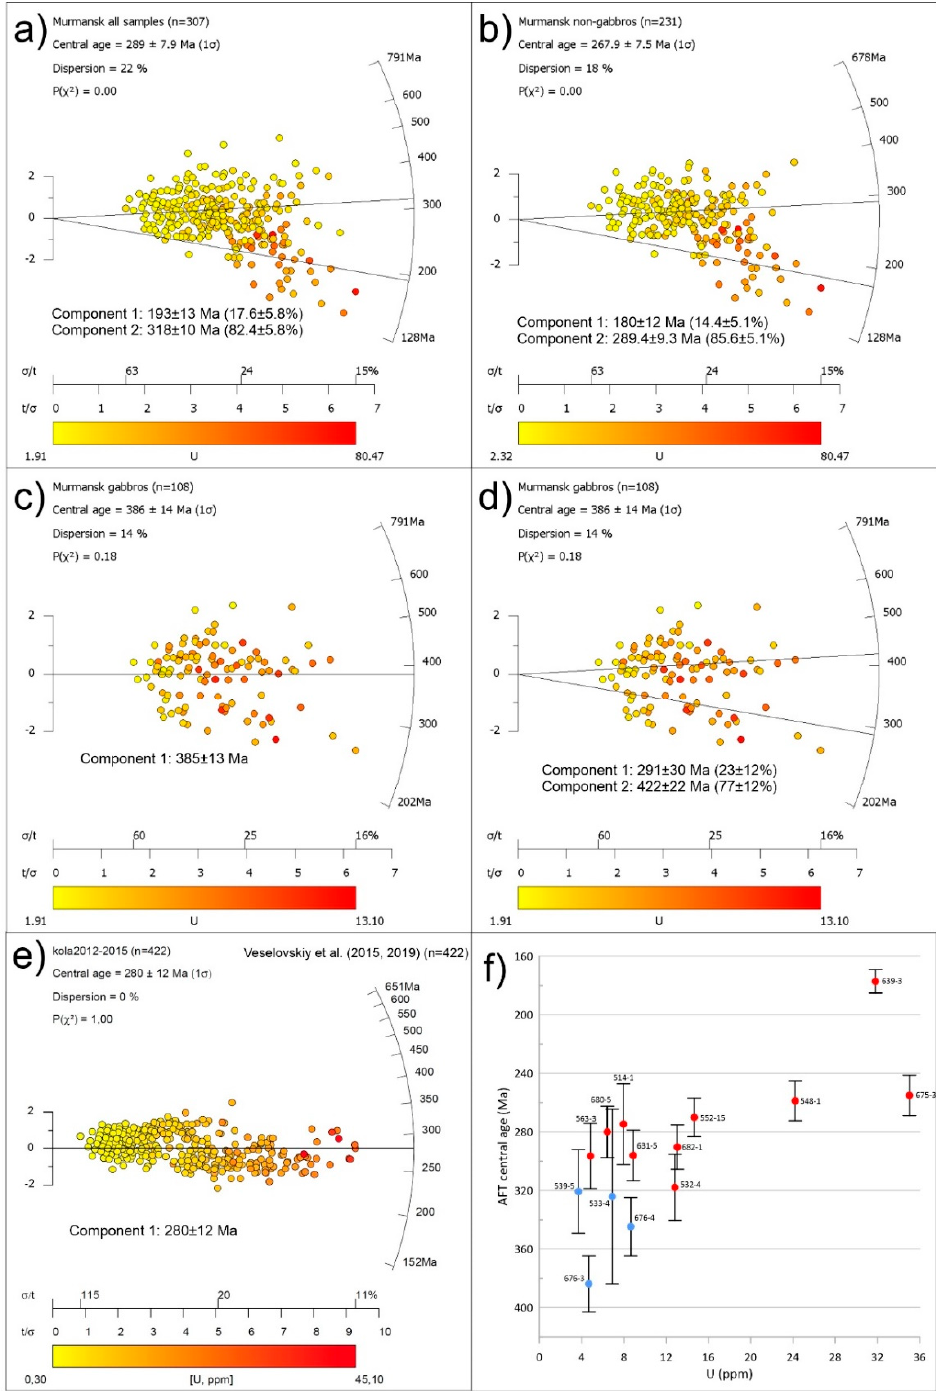
Figure 4. Radial plots presenting AFT age and uranium concentration dependence for ( a ) all samples studied in this work, ( b ) non-gabbro samples, ( c , d ) gabbro samples and ( e ) all previously studied samples from the Central Kola terrane [1,7]; ( f ) dependence of the mean U content in apatite from each sample with corresponding central AFT age; blue points represent the gabbro samples.